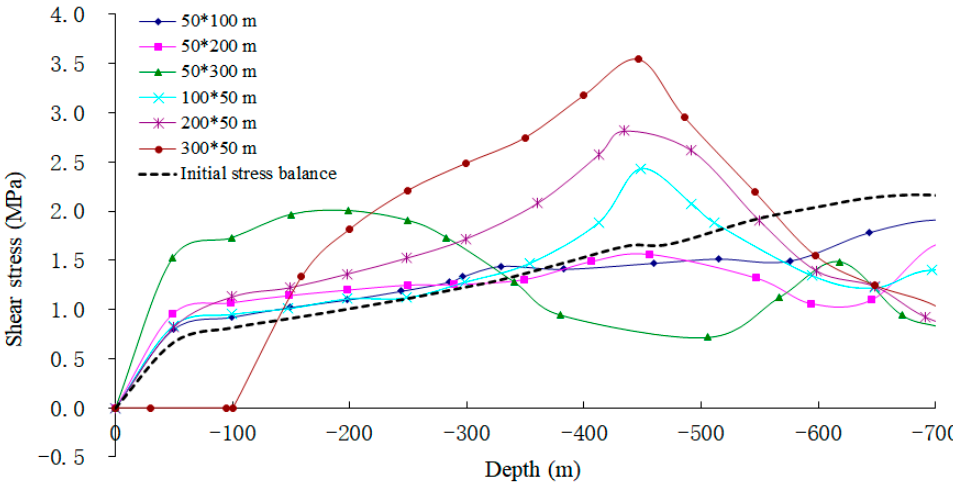
Figure 21. Shear stress distribution at the fault plane with different mining sizes.